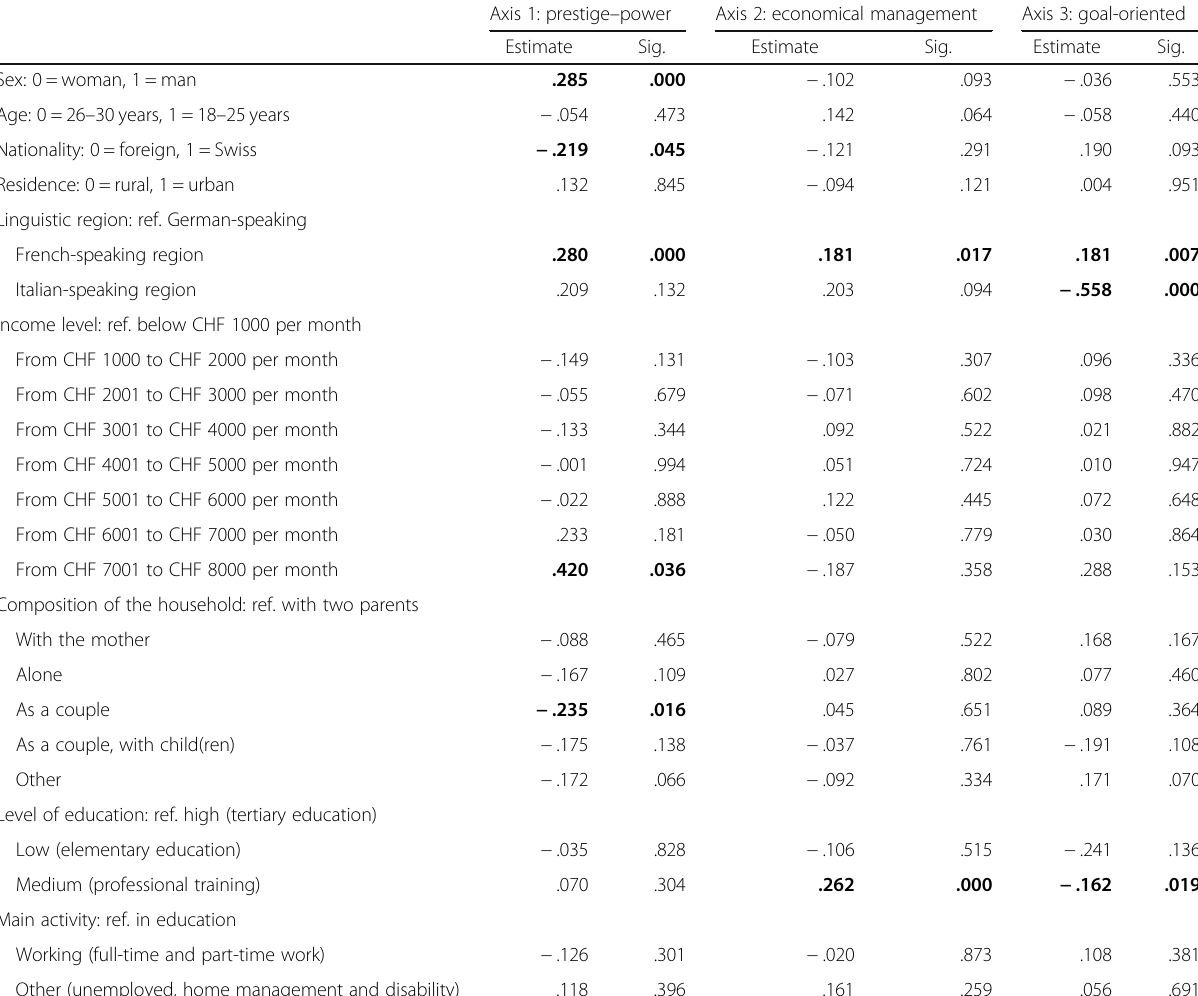
Table 3 Positioning on the attitude axes — multilevel linear regression Axis 1: prestige – power Axis 2: economical management Axis 3: